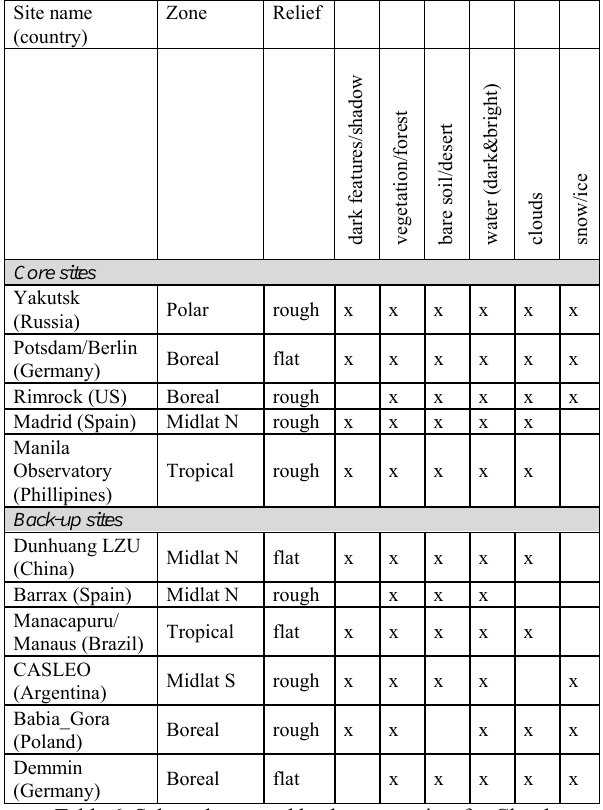
Table 6. Selected core and back-up test-sites for Cloud Screening and Scene Classification